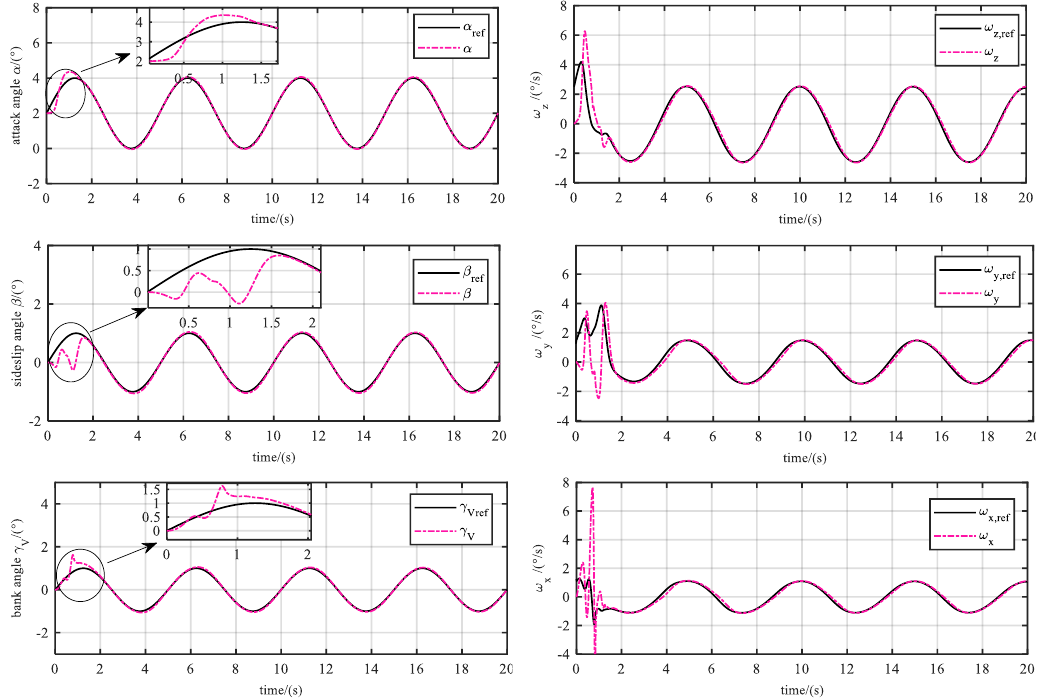
Figure 4. Tracking performance. The attack angle, sideslip angle, and bank angle response ( left ), and angular rates responses ( right ). It can be seen that the angles can follow the reference signals in about 2 s. There are certain oscillations in each channel to fully excite the identification and optimize the learning process.